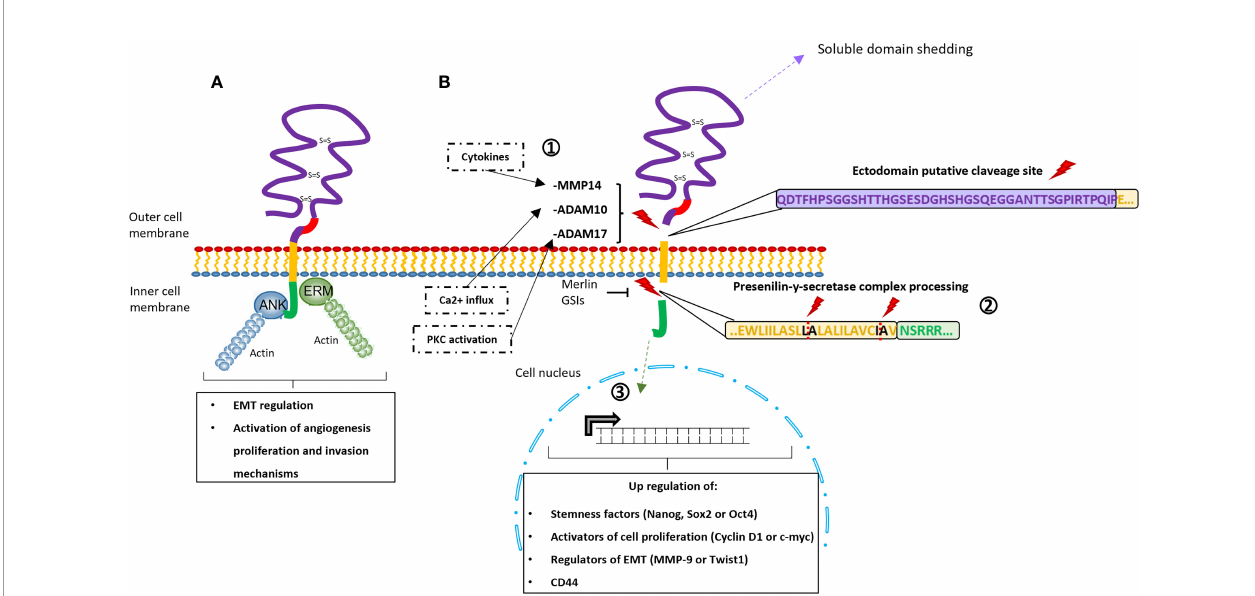
FIGURE 3 | Schematic representation of the signaling pathways activated through CD44. (A) Interaction between adaptor molecules Ankyrin (blue) and Ezrin-Radixin- Moesin (green) with the intracellular domain CD44-ICD. This interaction triggers modi fi cations in the cytoskeletal disposition and the activation of speci fi c pathways (e.g., c-Met activation, Ras-MAPK cascade, Snail/ b -catenin translocation, or PI3K-AKT pathway activation). As consequence, this via is involved in epithelial ‐ mesenchymal transition mechanisms (EMT) and the activation of angiogenesis, proliferation, and invasion mechanisms. (B) Schematic representations of CD44-ICD signaling via, including the sequential proteolytic cleavage of the CD44 protein. 1) The ectodomain shedding is induced by PKC, Ca2+ in fl ux or cytokines that activate the MMPs (ADAM17, ADAM10 and MMP14, respectively). 2) The presenilin-y-secretase complex is activated and processes the ICD through the speci fi c cleavage sites in the transmembrane domain (residues L-A and residues I-A). GSIs ( g -secretase inhibitors) and the merlin protein can inhibit this second proteolytic processing. 3) The ICD is released and translocated to the nucleus upregulating stemness factors, activators of cell proliferation, epithelial ‐ mesenchymal transition mechanisms (EMT) regulators and CD44